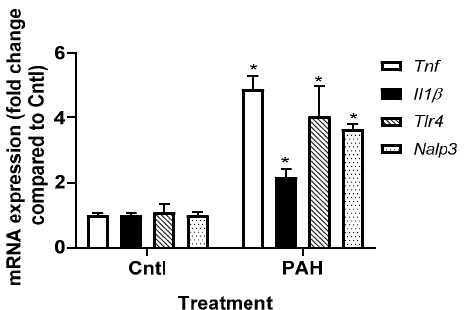
Figure 2. Expression of inflammatory mediator transcripts is increased in response to LMW PAH treatment inC10cells. C10cellsfollowing4hexposuretothePAHmixture(40 µ